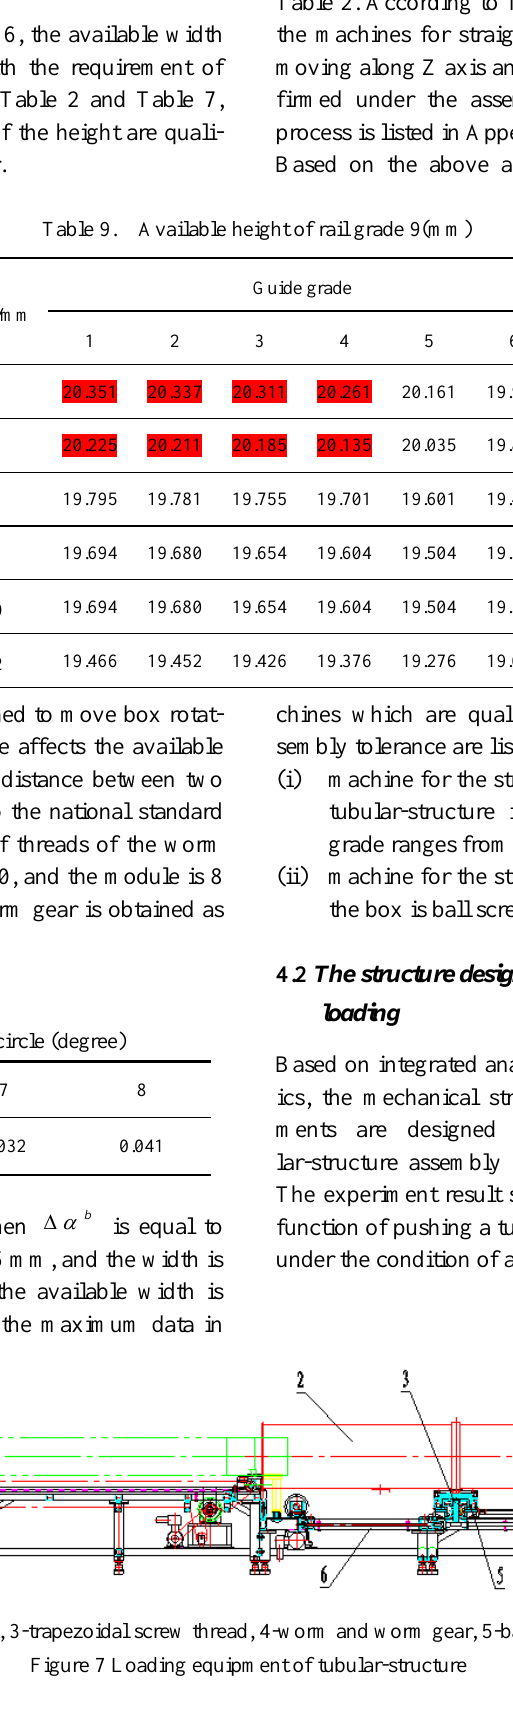
Table 2. According to Table 6, Table 9 and equation (7),